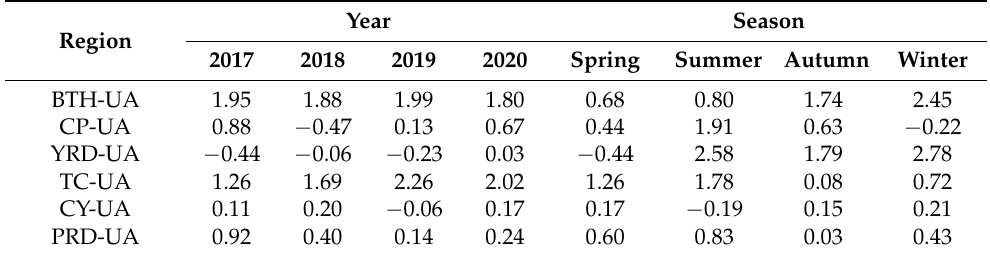
Table 1. Global Moran’s I index of PM 2.5 concentrations in different years and seasons.